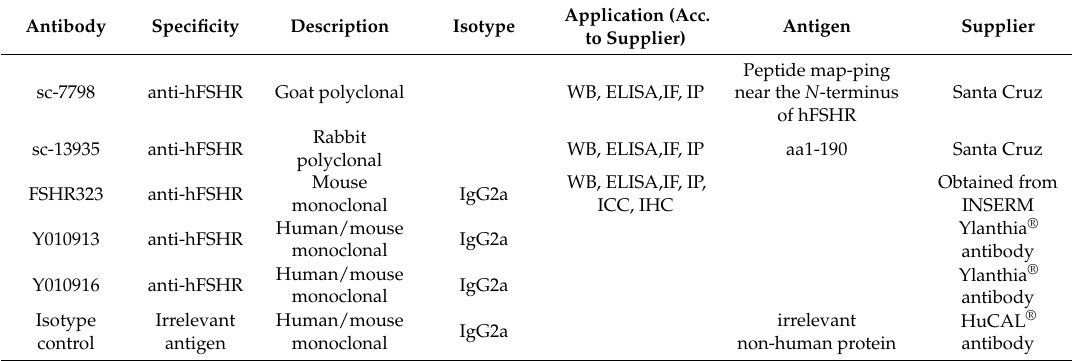
Table 1. Anti-hFSHR antibodies used in this study for cancer target validation of